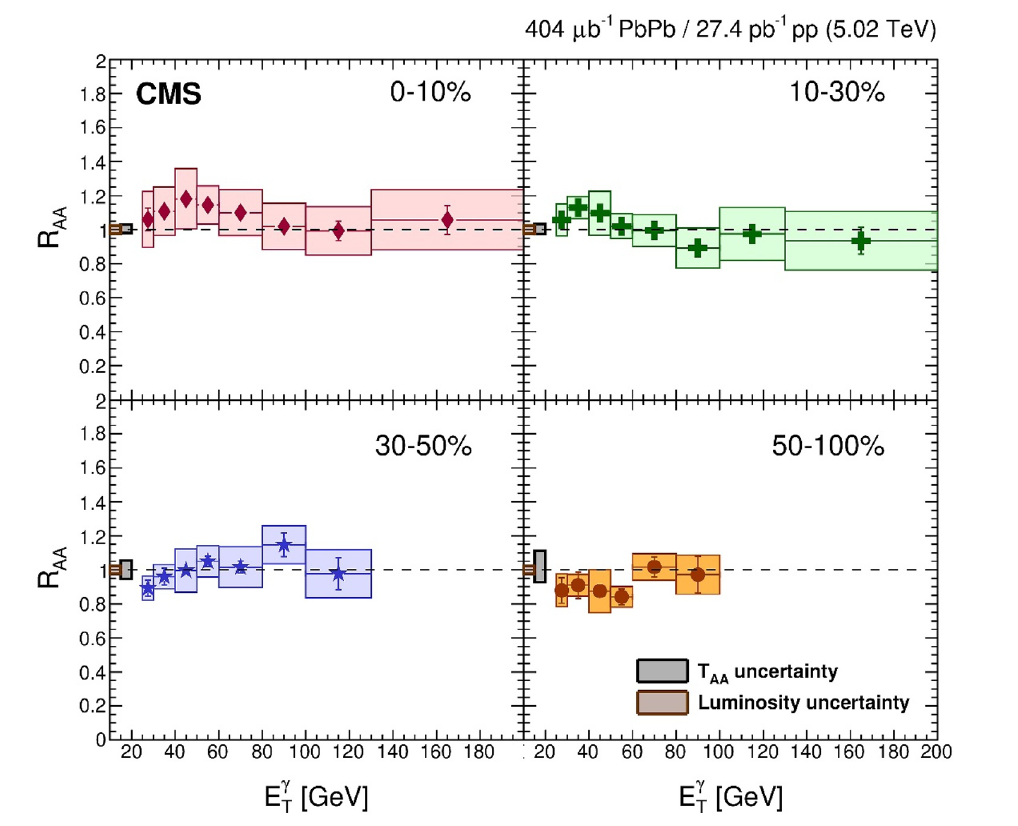
Figure 5 . Nuclear modi(cid:12)cation factors R as a function of the photon E g measured in the AA T 0{10%, 10{30%, 30{50%, and 50{100% centrality ranges in PbPb. The symbols are placed at the center of the bin. The vertical bars associated with symbols indicate the statistical uncertainties and the horizontal bars re(cid:13)ect the bin width. The total systematic uncertainties without the T AA uncertainty are shown as the colored boxes. The T uncertainty, common to all points for a given AA centrality range, is indicated by the gray box centered at unity on the left side of each panel. The 2.3% integrated luminosity uncertainty for pp data is shown as the brown box at unity at the leftmost